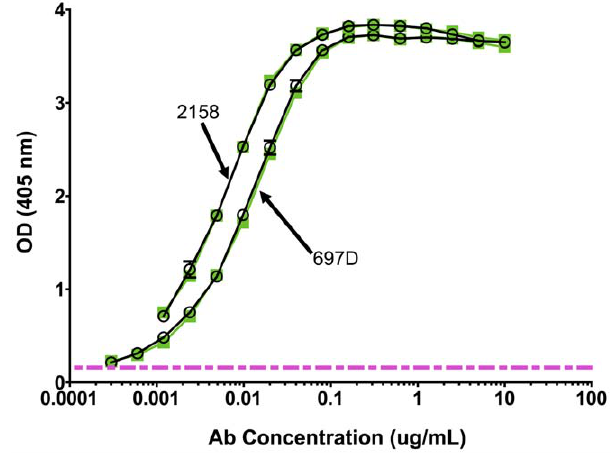
Figure 2. ELISA reactivity of human anti-V2 mAbs 697-D and 2158 with AIDSVAX subtype E (A244, green square) and AIDSVAX subtype B (MN, O) gp120 immunogens. The pink dashed line represents twice background levels.